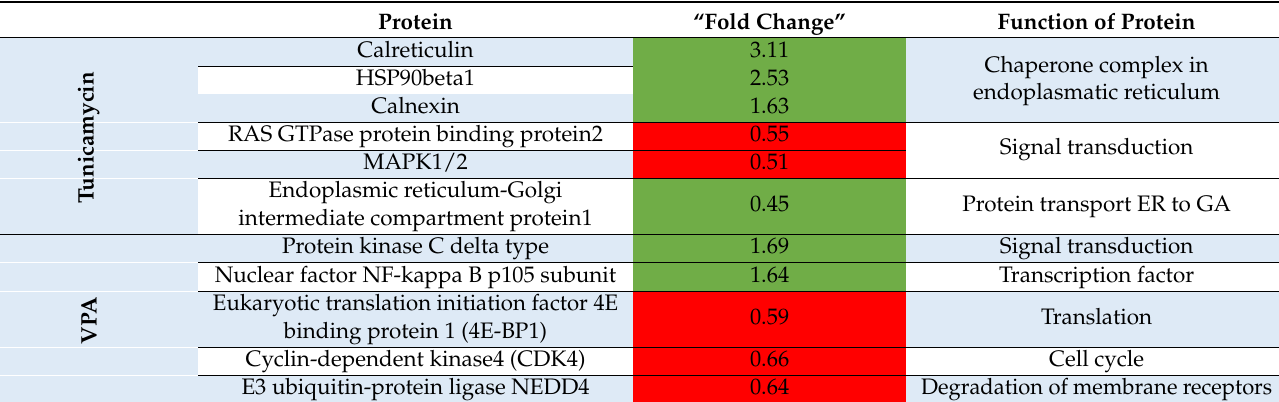
Table 1. Differential protein expression of Ba/F3-ITD (G613E) cells after incubation with either 1 µ g/mL tunicamycin or 1 mM VPA for 48 h. Whole proteome analysis was performed in triplets by liquid chromatography–tandem mass spectrometry (LC-MS). All indicated fold changes were statistically significant ( p < 0.05) while red and green colored illustrating down- and upregulation,